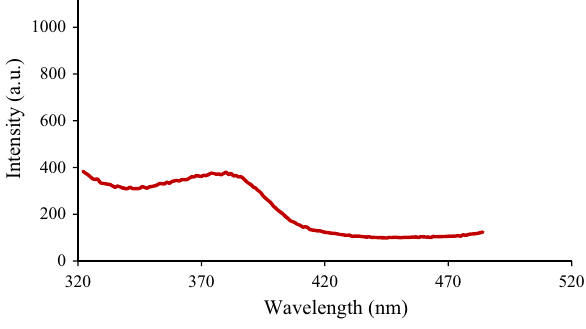
Fig. 8 Photoluminescence spectrum of Fe +3 –TiO